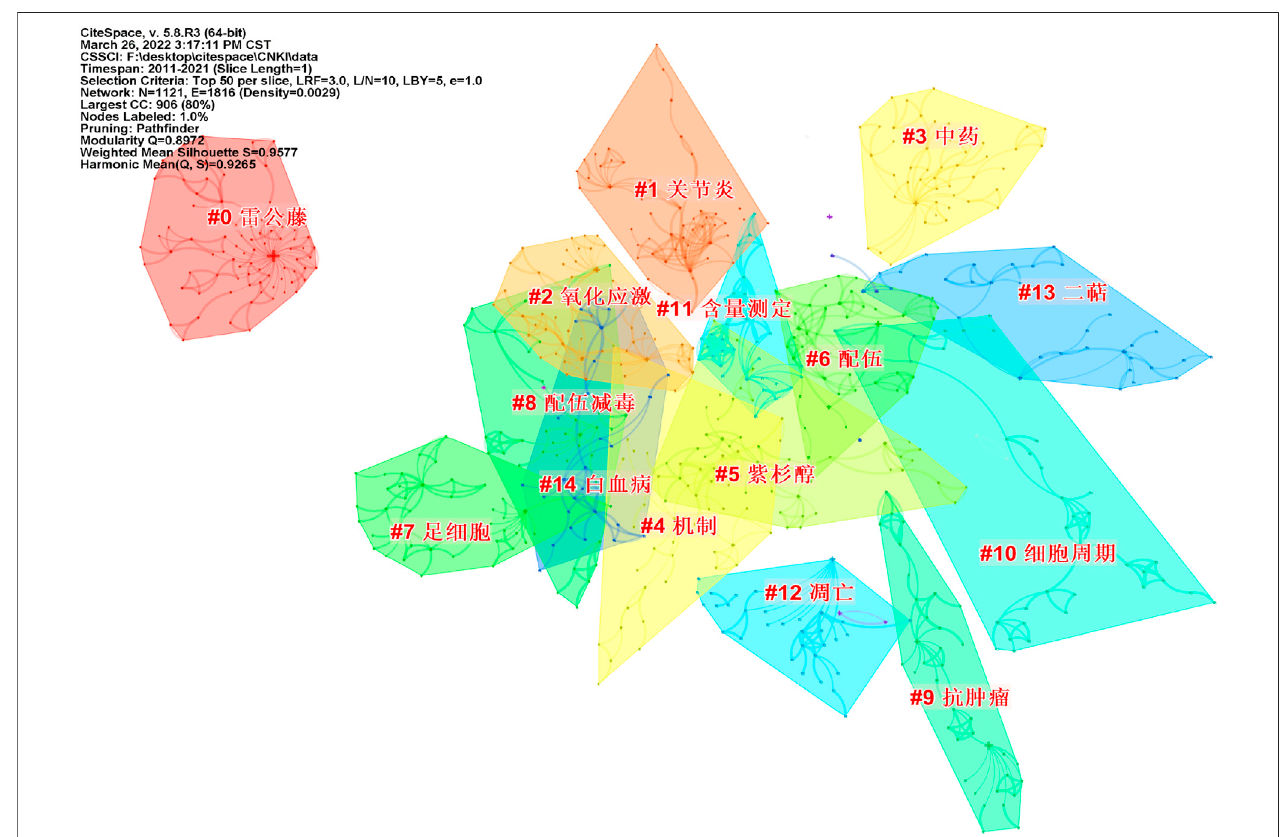
FIGURE 8 | Clustering network of keywords from the CNKI.